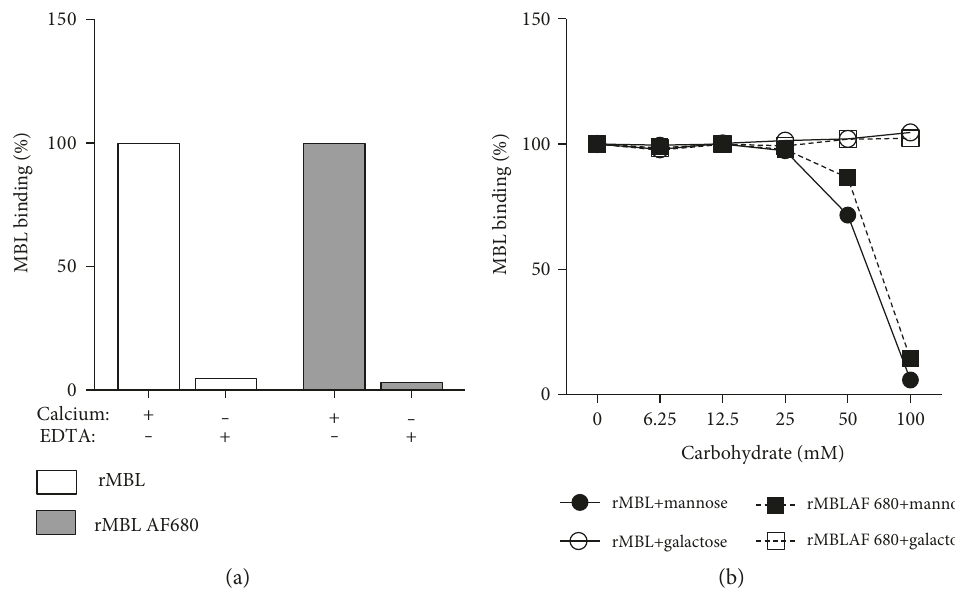
Figure 4: Test for preserved functionality of labelled rMBL. (a) Unlabelled and labelled rMBL were incubated on mannan-coated plates in calcium- or EDTA-containing bu ff ers. Values measured in calcium bu ff er were de fi ned as 100%, and subsequent samples were calculated according to these. (b) Unlabelled and labelled rMBL were incubated on mannan-coated plates in the presence of either mannose or galactose. Values acquired in the presence of galactose were de fi ned as 100%, and subsequent samples were calculated according to these. Representative of two individual